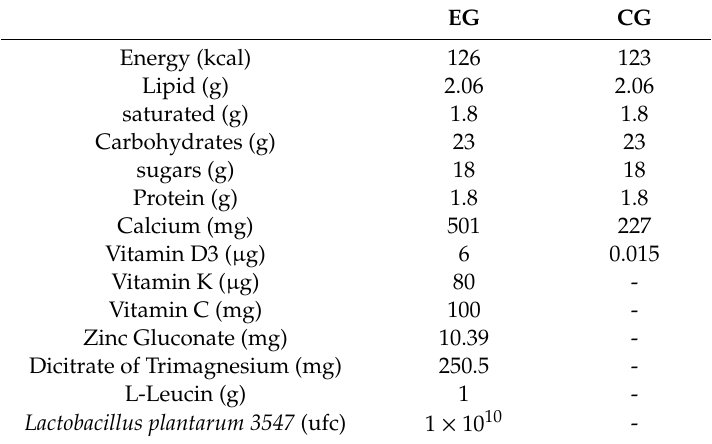
Table 1. Nutritional composition of products (150